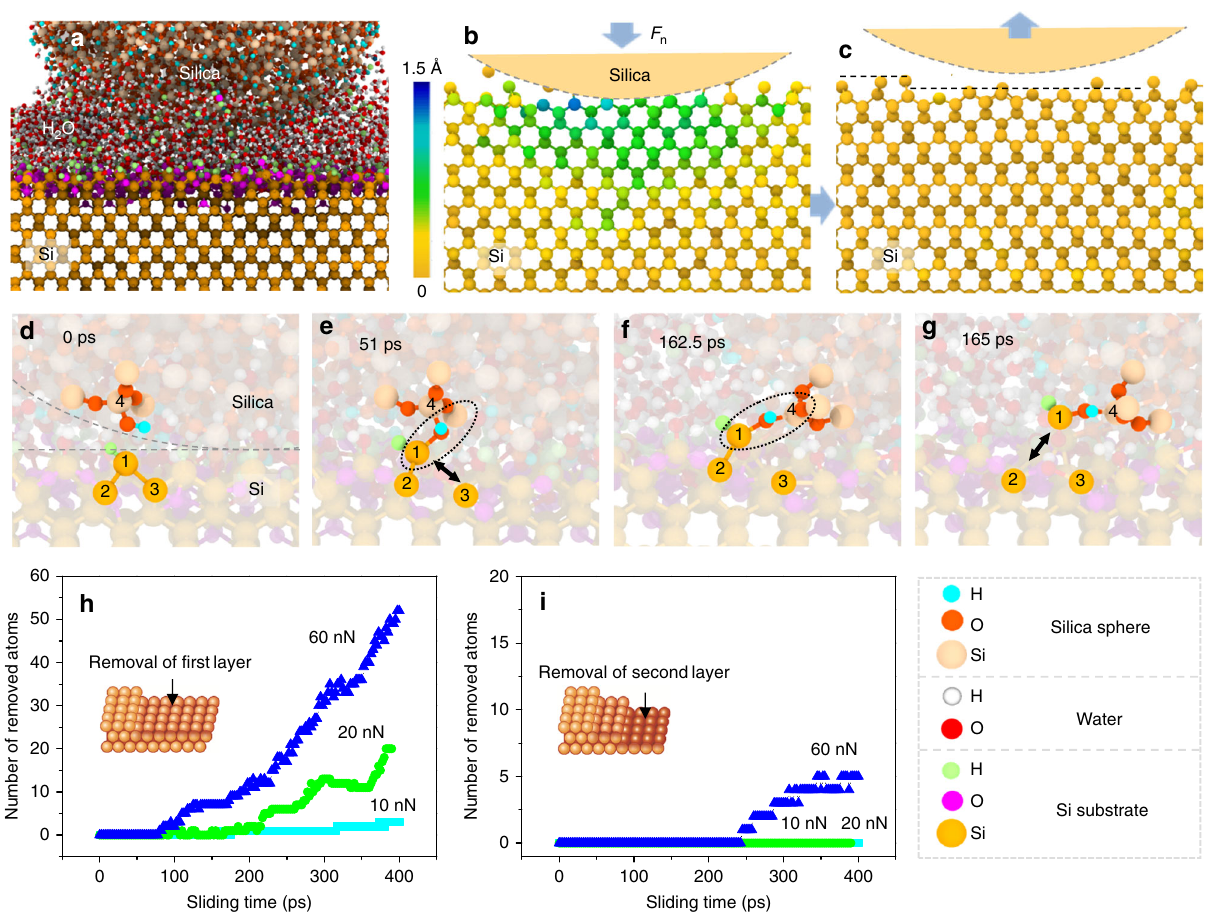
Fig. 3 Atomic removal of Si surface against silica nano-sphere in MD simulation. a Sliding model in MD simulation. b Deformation of Si substrate under load condition (The Z direction displacement of Si atoms movement under contact pressure is denoted by different colors). c Removal of Si atoms and release of substrate deformation after unloading. d – g Mechanochemical reaction process: d Initial contact interface reacting with water to form Si – H and Si – OH groups (i.e., Si 2 – 3 = Si 1 – H on down Si substrate and O – Si 4 – OH on upper SiO 2 nano-sphere); e Formation of Si 1 – O – Si 4 interfacial bond bridge between Si substrate and silica surfaces, and breaking of Si 1 – Si 3 bond; f Tensile stress transferred across Si 1 – O – Si 4 bonding bridges; g Fracture of Si 1 – Si 2 bond and the atom Si 1 removed from Si substrate. h and i respectively show the number of Si atoms removed from the fi rst atomic layer (inset schematic in h ) and second atomic layer (inset schematic in i ) as a function of sliding time under different load